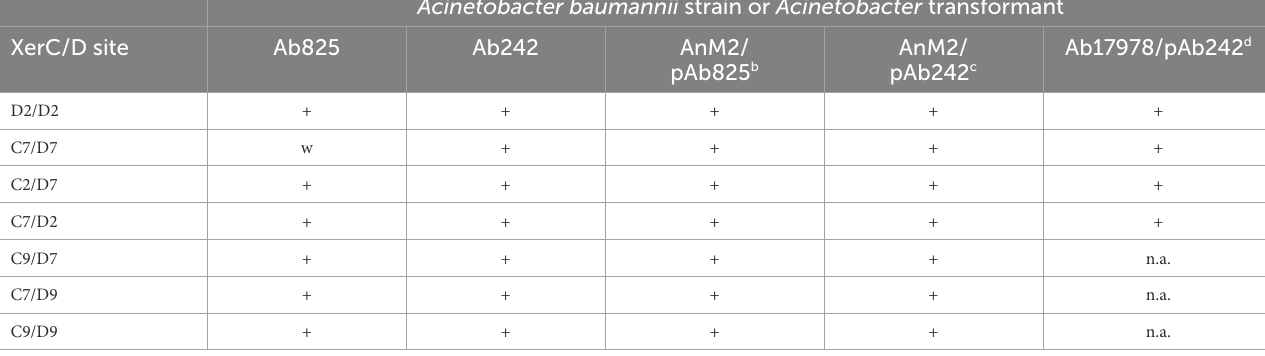
TABLE 2 Summary of the PCR evidence for the coexistence of different plasmid structural variants containing inversions and fusions resulting from SSR mediated by active pairs of pXerC/D sites in clonal populations of the different Acinetobacter strains analyzed. a Acinetobacter baumannii strain or Acinetobacter transformant